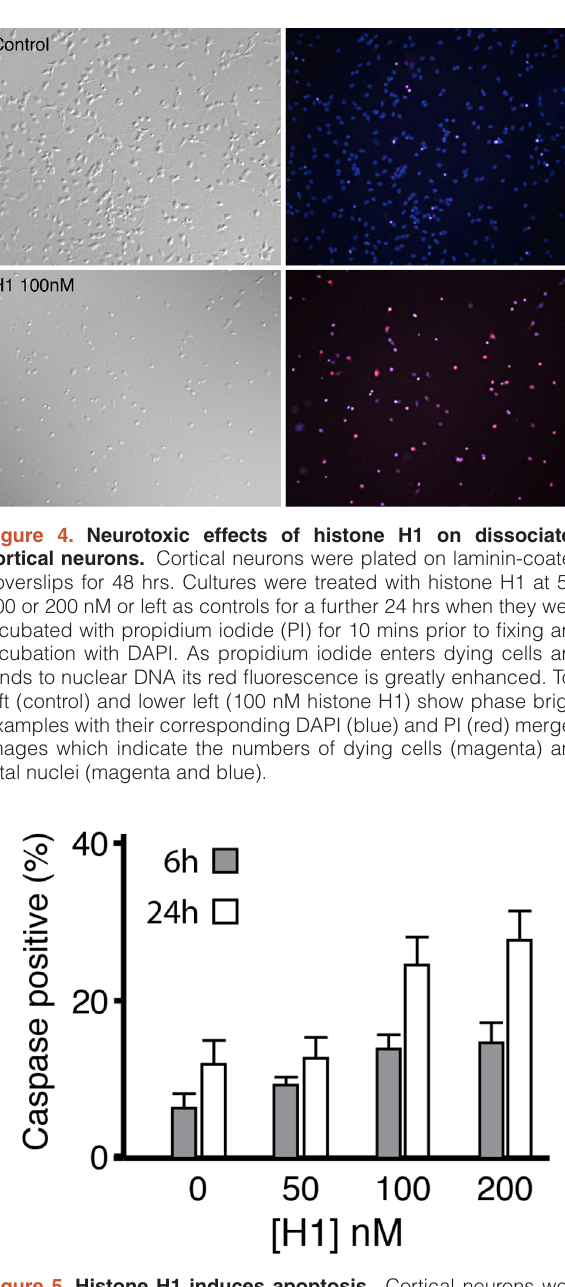
Figure 5. Histone H1 induces apoptosis. Cortical neurons were plated on laminin-coated coverslips and treated with histone H1 at 50, 100 and 200 nM for 6 hrs and 24 hrs. Cells were fixed and stained with DAPI (total nuclei) and for activated caspase 3 to detect apoptosis. Counts for both DAPI and caspase 3 were made for between 11–14 random fields per coverslip for each condition